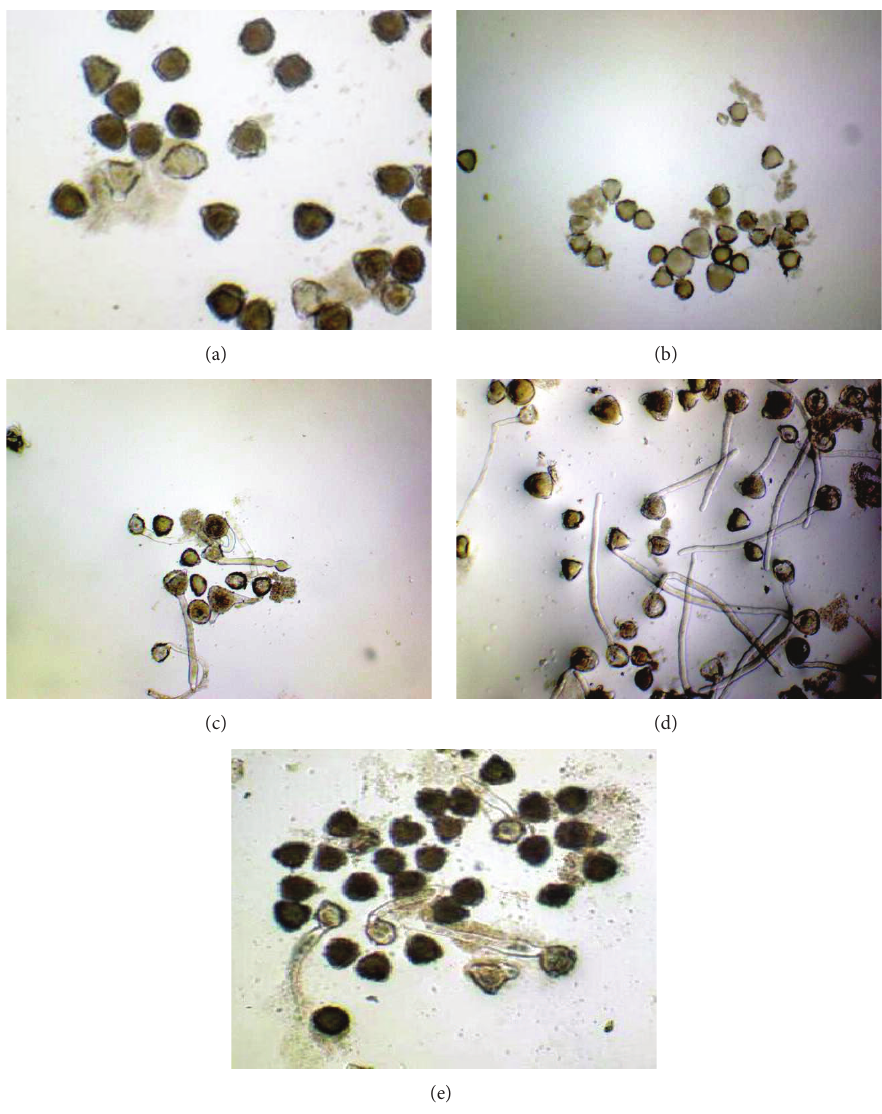
Figure 2: Pollen germination in media containing different sucrose concentrations after 24 hours of germination ((a) 0%, (b) 5%; (c) 10%; (d) 15%, and (e) 20% sucrose) ( × 100).